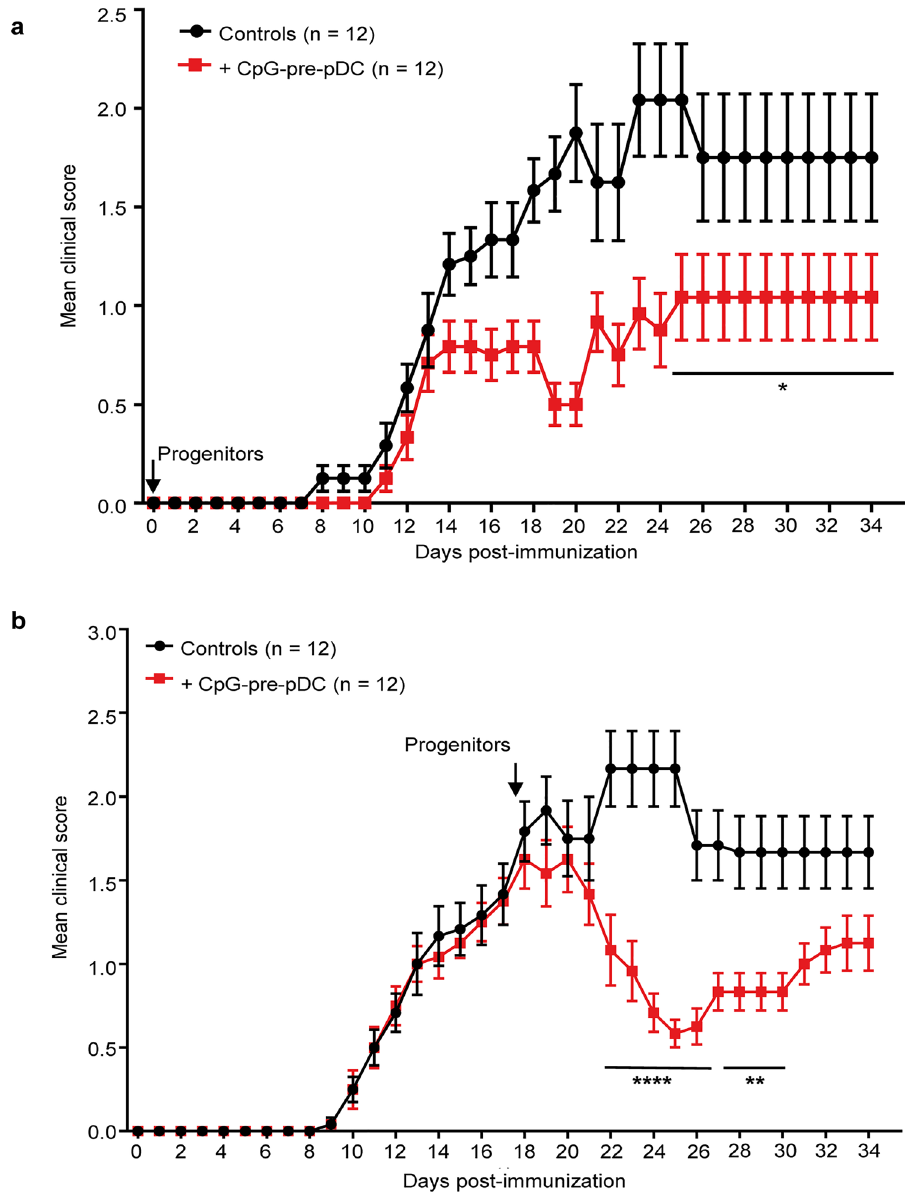
Figure 7. Extended therapeutic window of CpG-pre-pDCs against EAE. CpG-pre-pDCs, 80,000 per recipient, were adoptively transferred either ( a ) at d-0 (n = 12 mice per group), or ( b ) at d-17 (n = 12 mice per group) after immunization. Clinical scores were assessed until day-35. Data are from 2 cumulated experiments. Statistical analysis was performed using two-way ANOVA with Bonferroni post-test, ( a ) d25–d34, *, p = 0.0453, ( b ) d22– d26, ****, p < 0.0001, d27–d30, **, p =